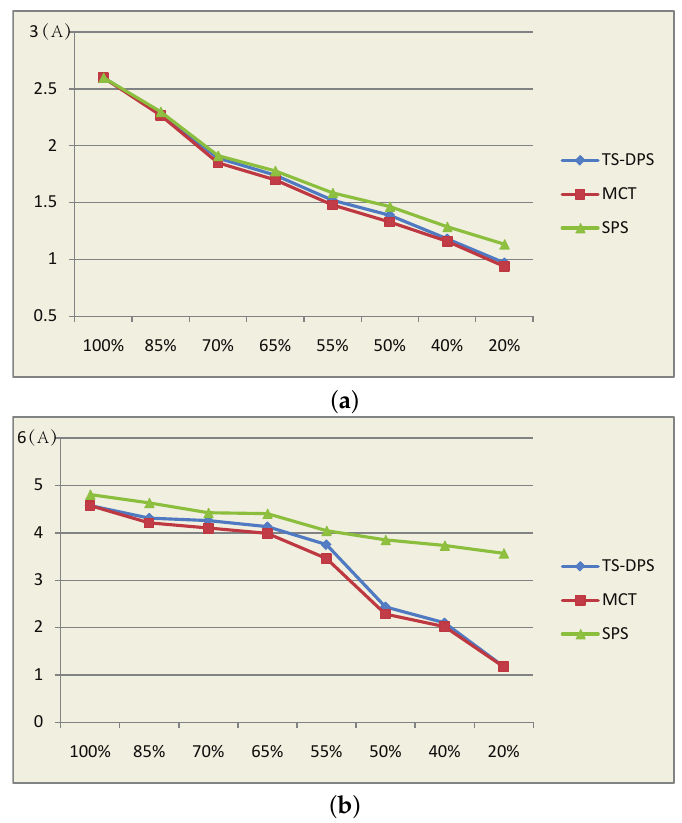
Figure 15. Comparison of the measured rms resonant current under different load levels under SPS, PW-DPS, and MCT control: ( a ) M = 0.96; ( b ) M = 0.576.